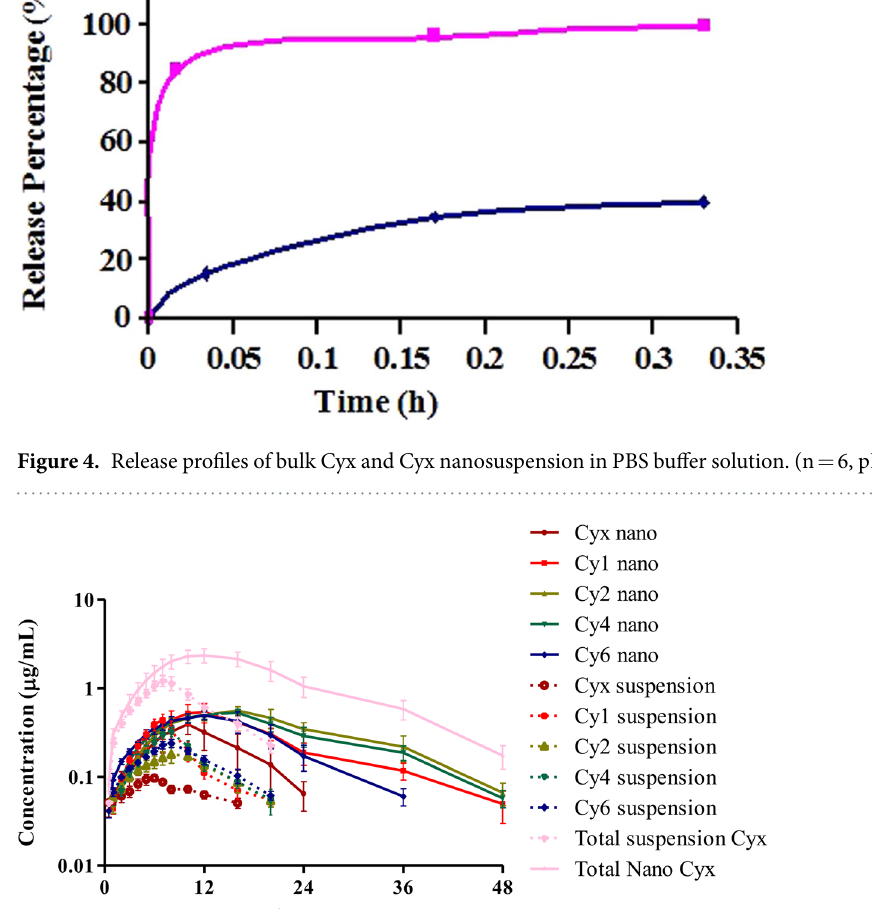
Figure 5. Concentration of prototype and metabolite vs. time curves of Cyx nanosuspension and bulk Cyx after oral administration at dose rate 40 mg/kg b.w. in Beagle